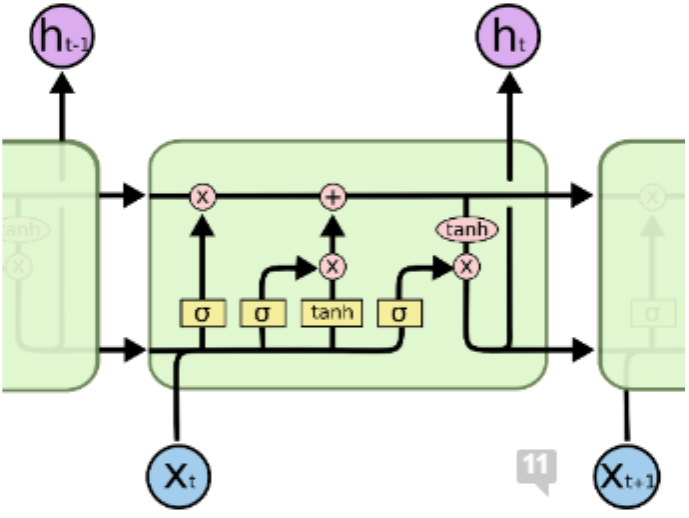
Figure 6. The process of training the LSTM network [25]. The basis of LSTM is a horizontal line through which a vector passes between in- dividual blocks. Using this line, information passes through the entire structure of the LSTM network. There are gates in individual cells. These gates are used to remove or add information to the state of the block. Information (vector) passes through these gates, which are composed of neurons with a sigmoidal activation function. Depending on the value of the output on these neurons, so much information passes through it, while 0 means that no information passes through the neuron (i.e., the gate), and 1 means that everything passes through the gate. Each LSTM block contains three such gates (input gate, forget gate and output gate), which are used to adjust the state in which the individual blocks are